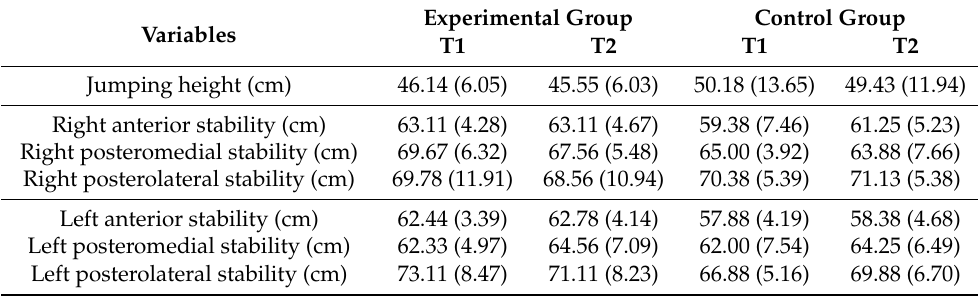
Table 2. Descriptive statistics (mean and standard deviation) of the study variables at posttreatment